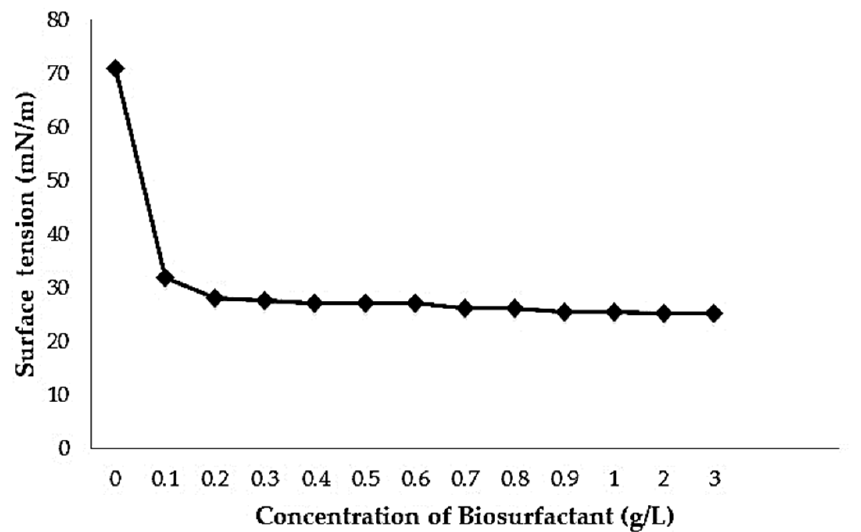
Figure 1. Critical micelle concentration of the biosurfactant produced by Candida sphaerica cultivated in medium supplemented with 9% vegetable oil refinery residue and 9% corn steep liquor.